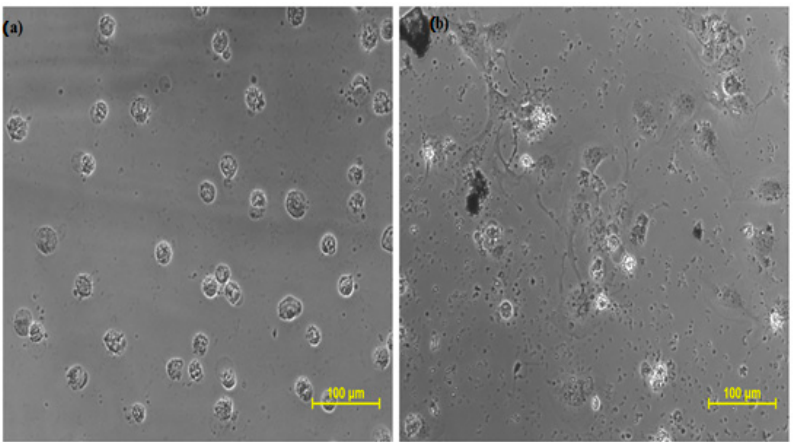
Figure 4. Cytotoxic effect of ( a ) Doxorubicin and ( b ) longifolene on SCC-29B cells. Figure 5. Effect of Doxorubicin and longifolene on Vero cells (normal kidney cell line): ( a ) Vero cells treated with Doxorubicin ( b ) Vero cells treated with longifolene. Table 4. Cytotoxicity profile with IC 50 (µg/mL) values of longifolene and doxorubicin.